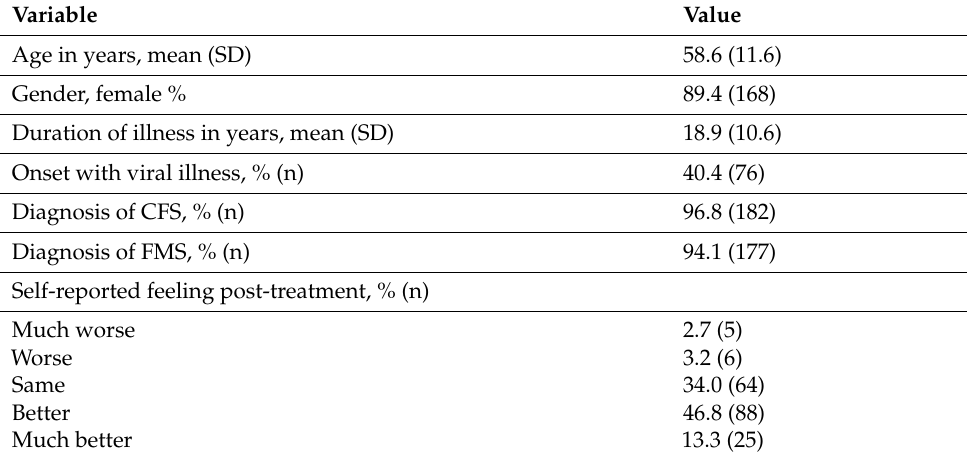
Table 1. Sample Characteristics ( n = 188).